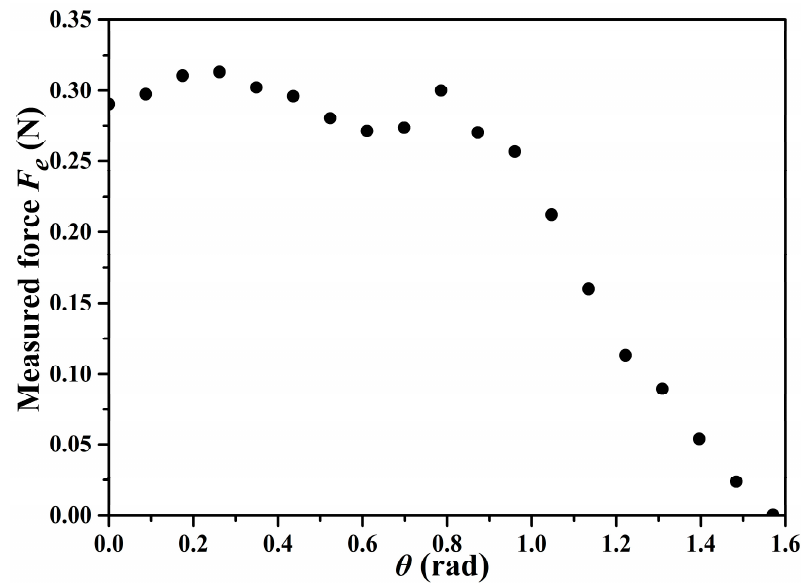
Figure 9. The measured F e as a function of the angle of the paddle θ .